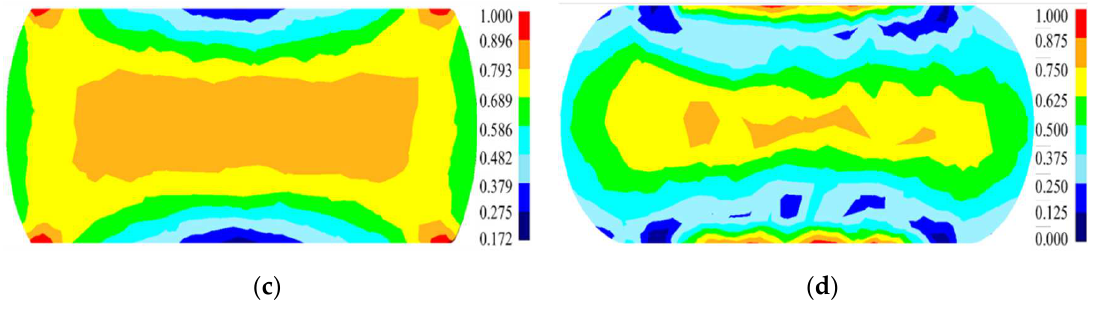
Figure 22. The distribution of the simulated X drx at ( a ) 1110 °C/0.1 s −1 ; ( b ) 1140 °C/0.1 s −1 ; ( c ) 1110 °C/0.01 s −1 ; and ( d ) 1110 °C/1 s −1 .